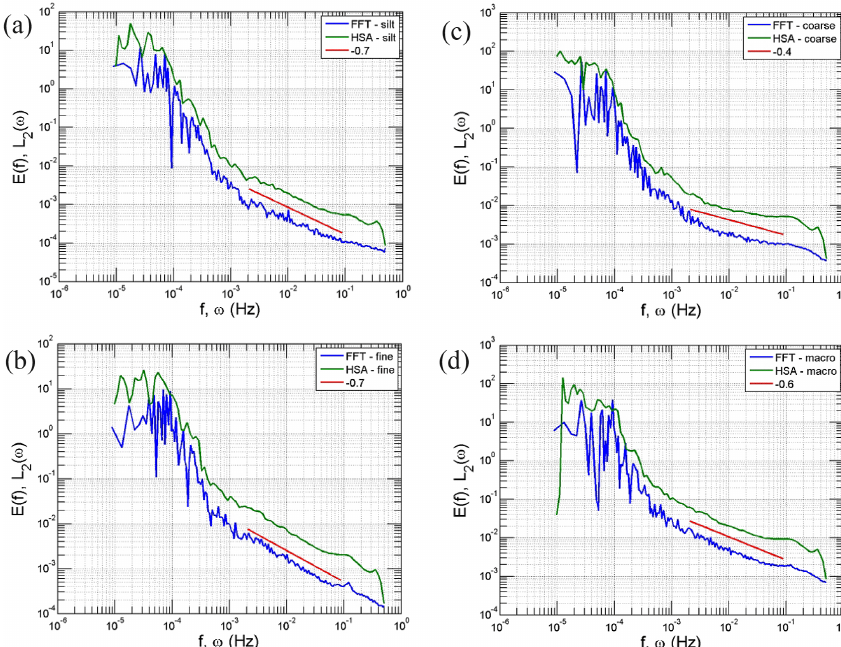
Figure 6. Power spectra for different size classes of PSD estimated for Fourier and Hilbert transforms. Silt/clay (a) , fine (b) , coarse/micro (c) and macro particles/flocs (d) . The red lines shows the scaling range and the slope of the best fit in this range.